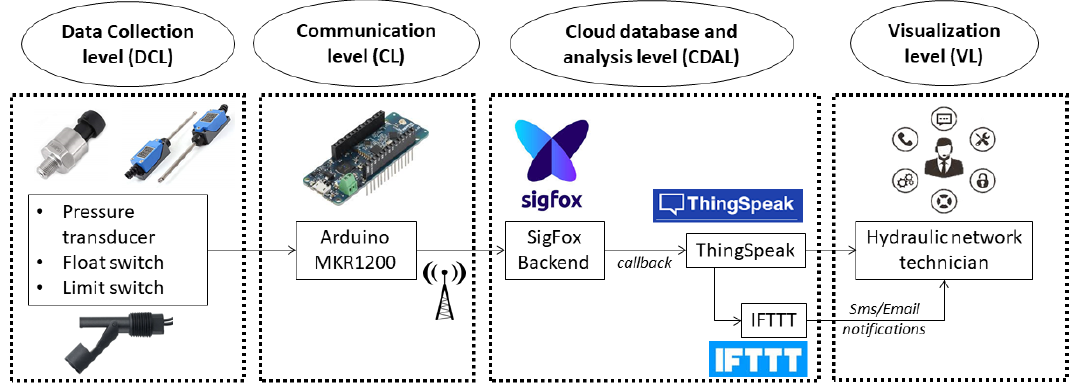
Figure 2. Internet of Things (IoT) pressure monitoring system (IPMS) architecture.